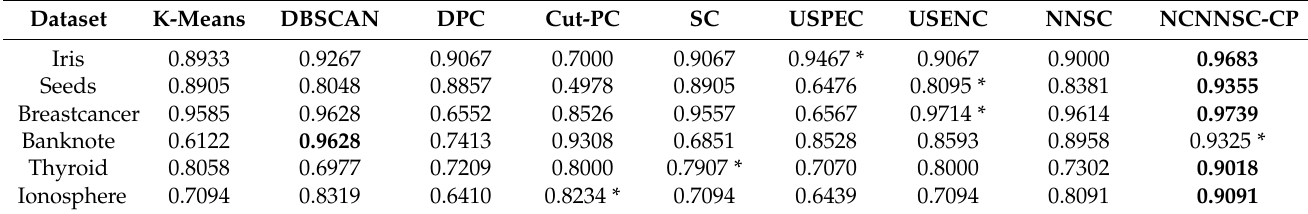
Table 3. The Accuracy of the nine algorithms on six UCI datasets.